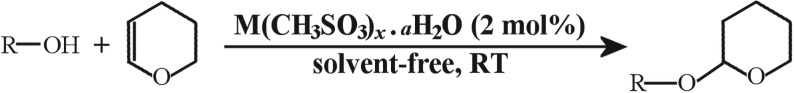
Tetrahydropyranylation of an alcohol catalysed by a metal methanesulfonate.